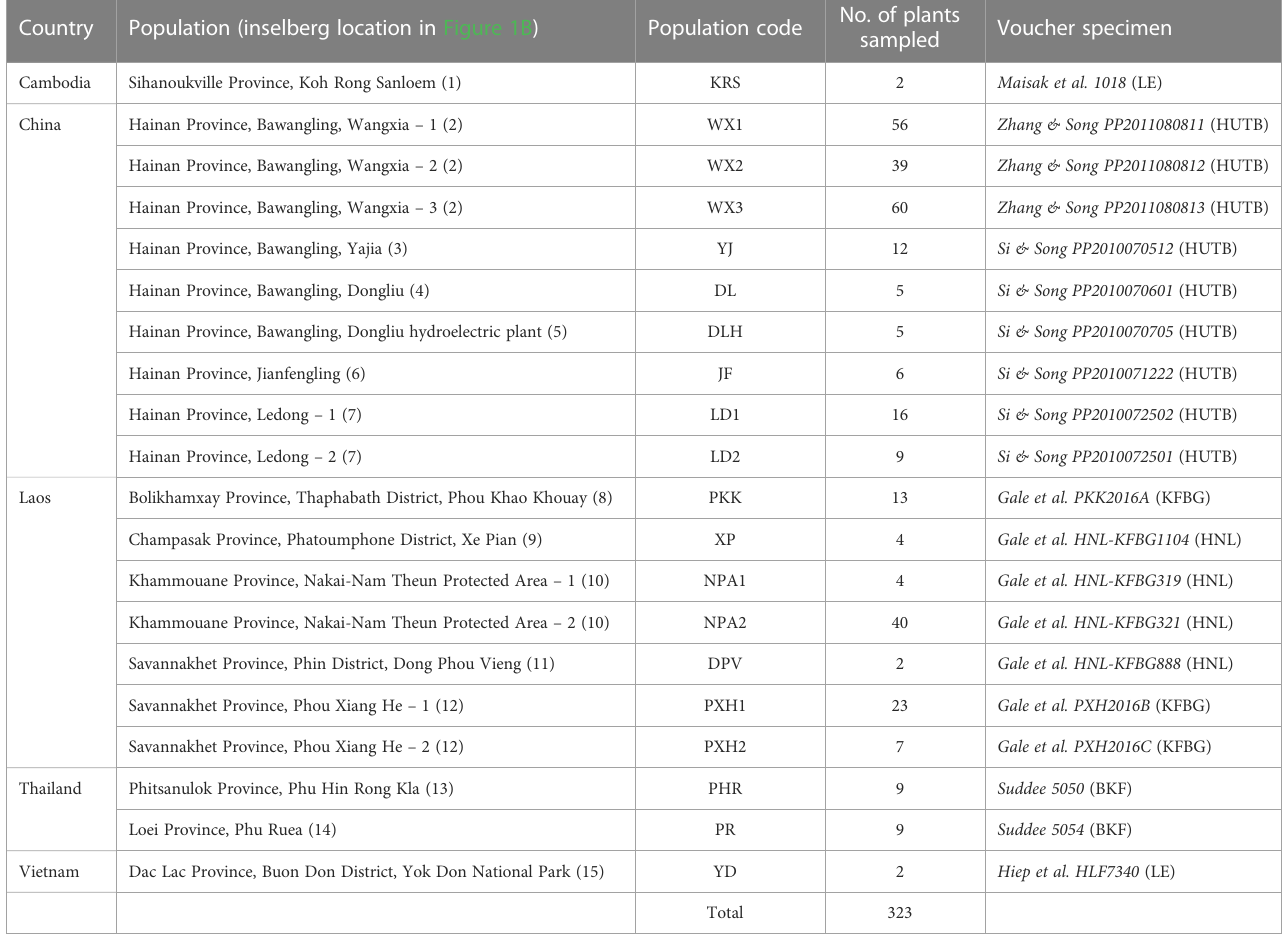
The number in parentheses after the population name indicates the inselberg location as shown in Figure